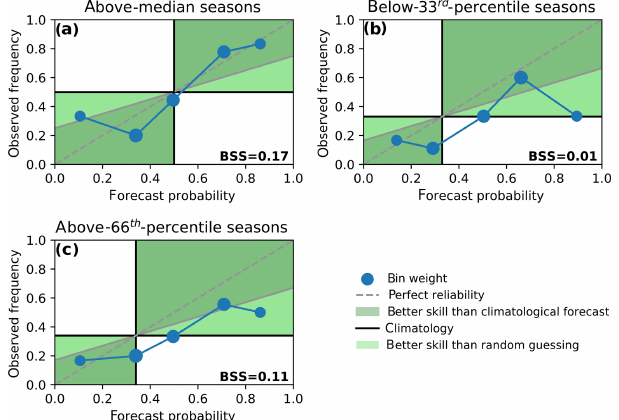
Figure 9. Reliability diagrams for a logistic regression model on March precursors. As Fig. 6 but for